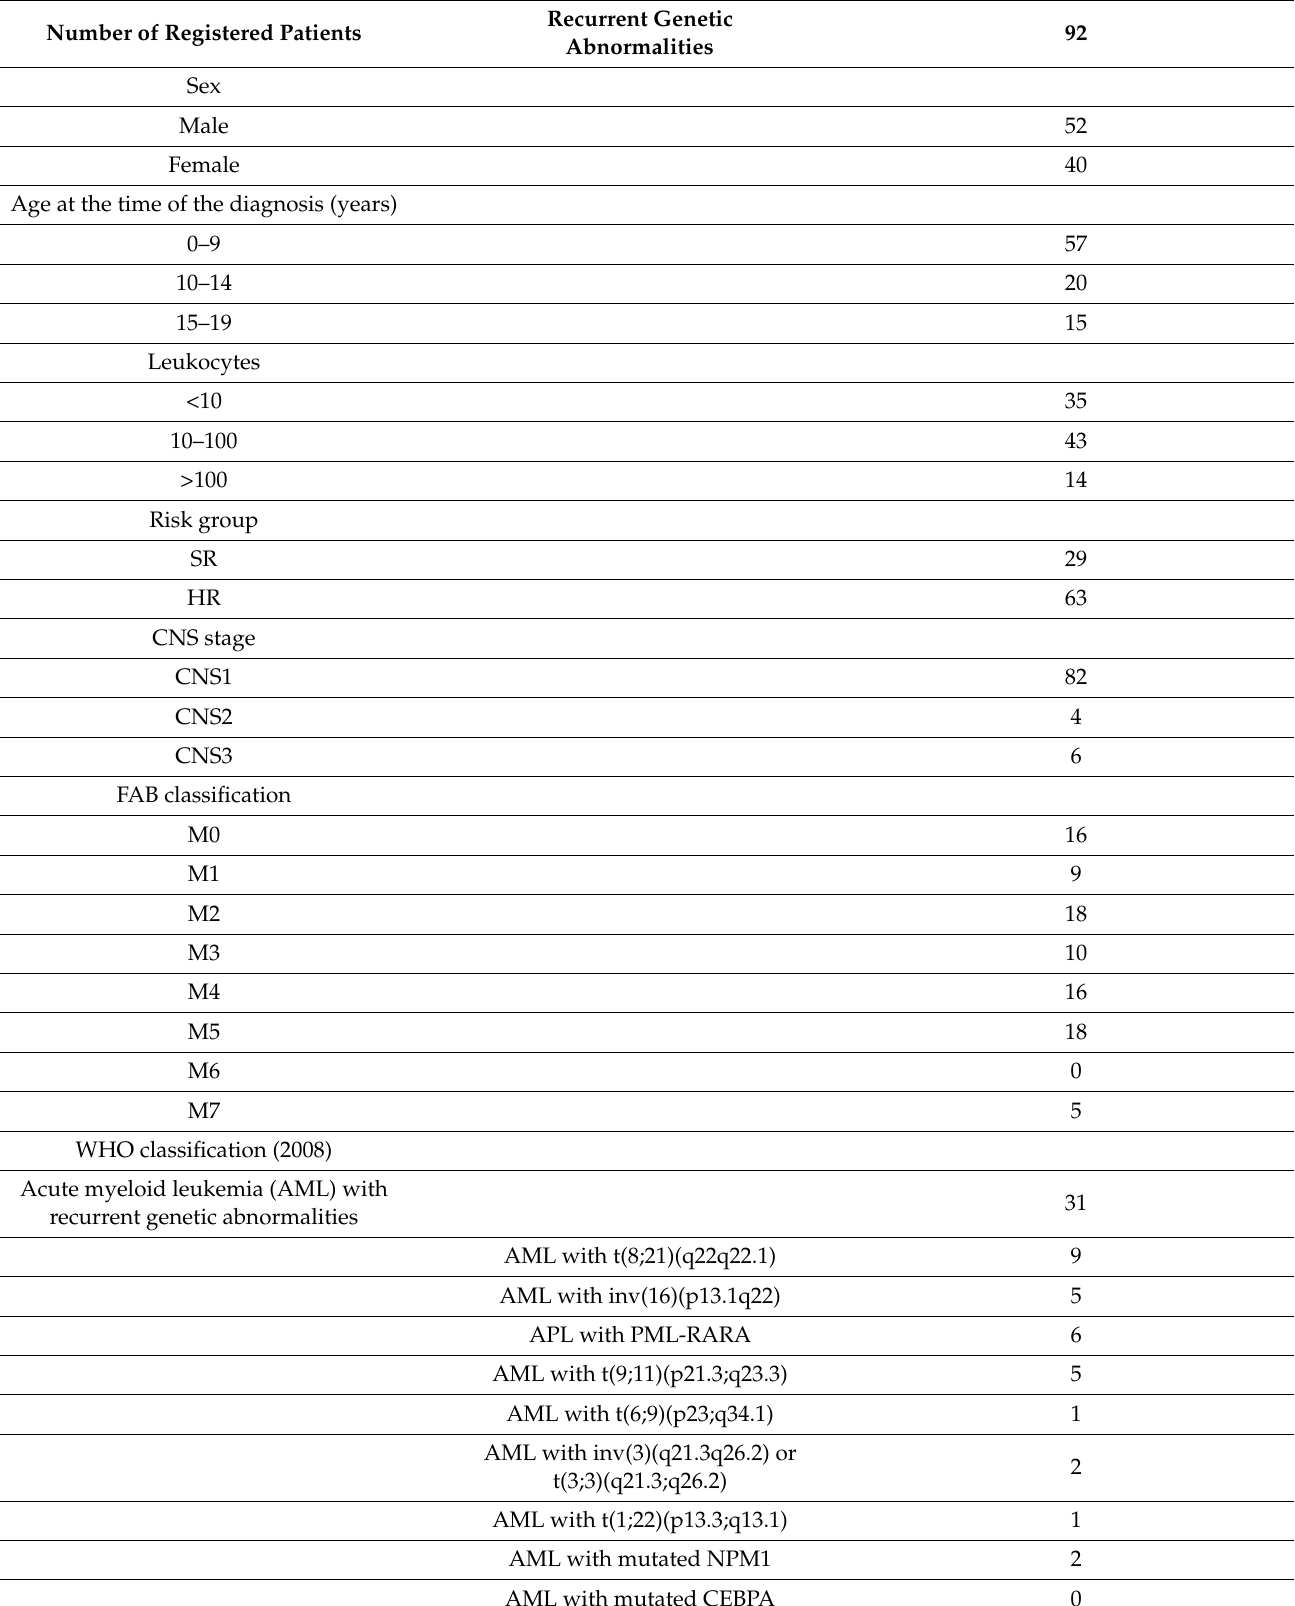
Table 1. Clinicopathological characterization of pediatric AML patients registered in the Hungarian Childhood Tumor Register between 2012 and